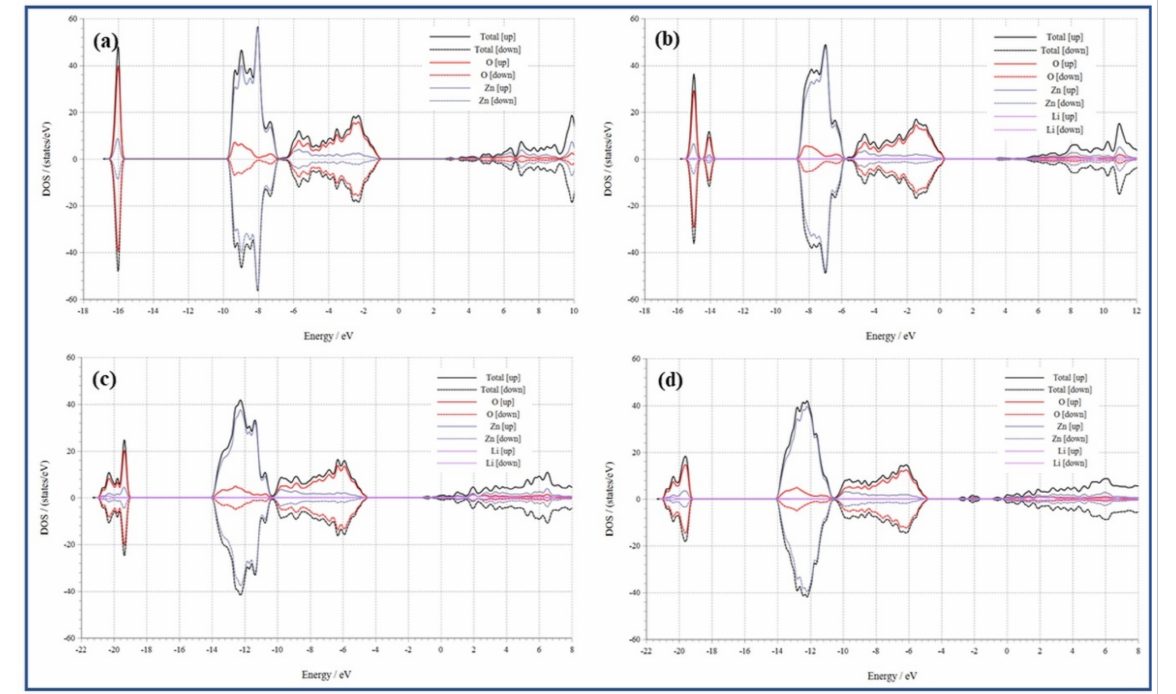
Figure 7. Density of states for ( a ) Zn 16 O 16 , ( b ) Zn 15 LiO 16 , ( c ) Zn 16 Li in O 16 , and ( d ) Zn 16 Li in O 15